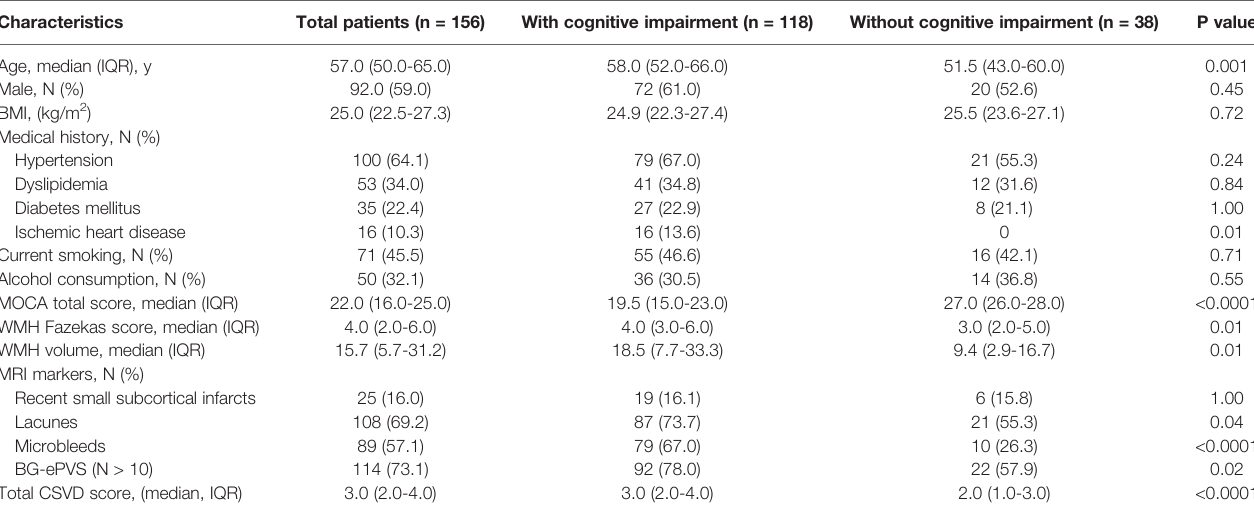
TABLE 1 | Clinical and radiological characteristics of the study population. Characteristics Total patients (n =